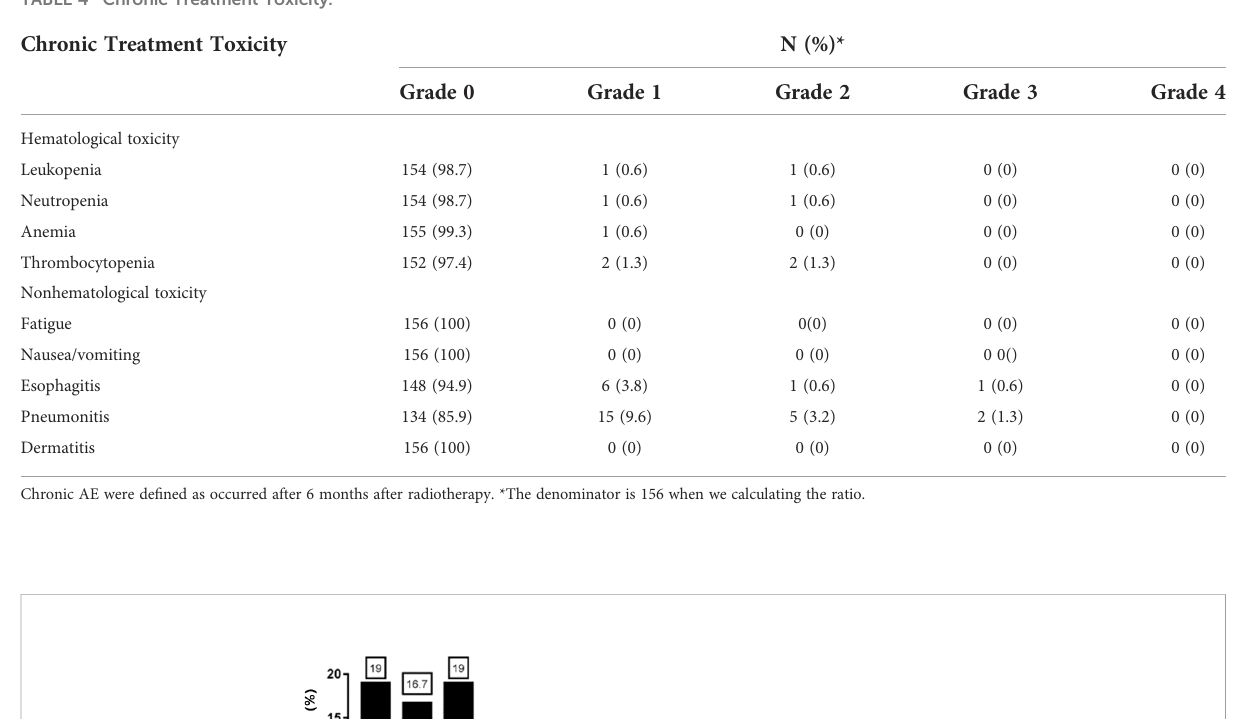
TABLE 4 Chronic Treatment Toxicity.